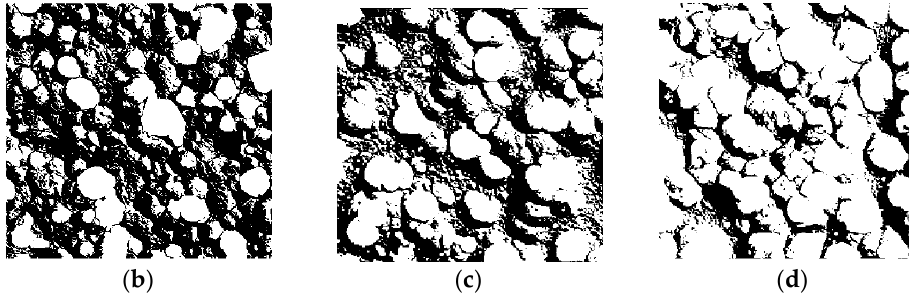
Figure 4. Binary image of corrosion characteristic region at different Cl − concentrations: ( a ) 50% [Cl − ] Std ; ( b ) 100% [Cl − ] Std ; ( c ) 150% [Cl − ] Std ; ( d ) 200% [Cl − ] Std .